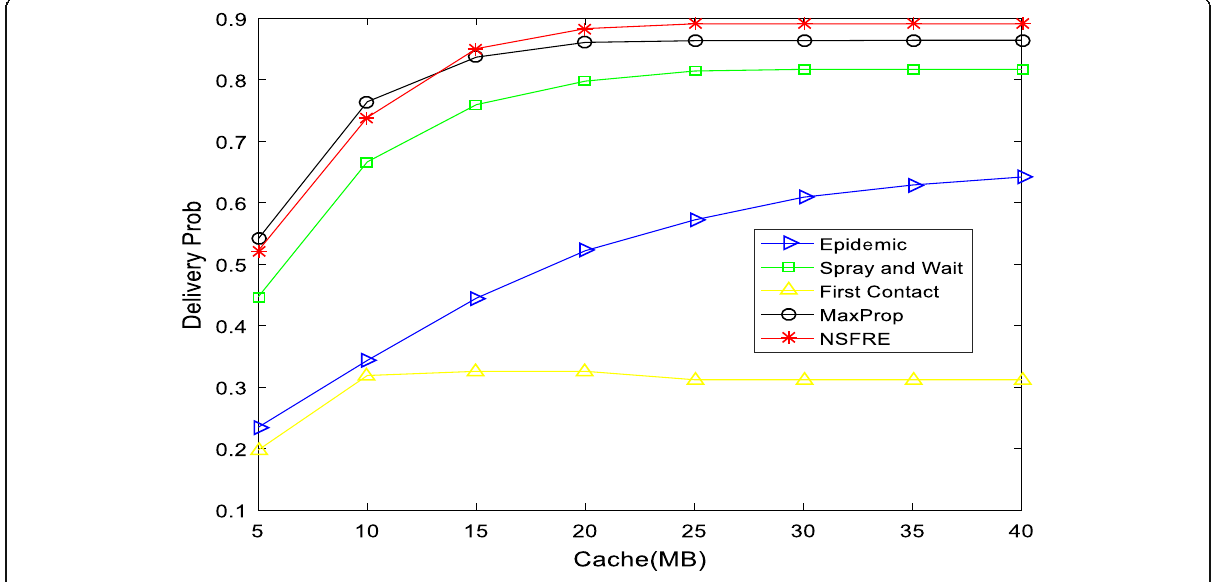
Fig. 10 The relationship between transmission success rate and the node cache